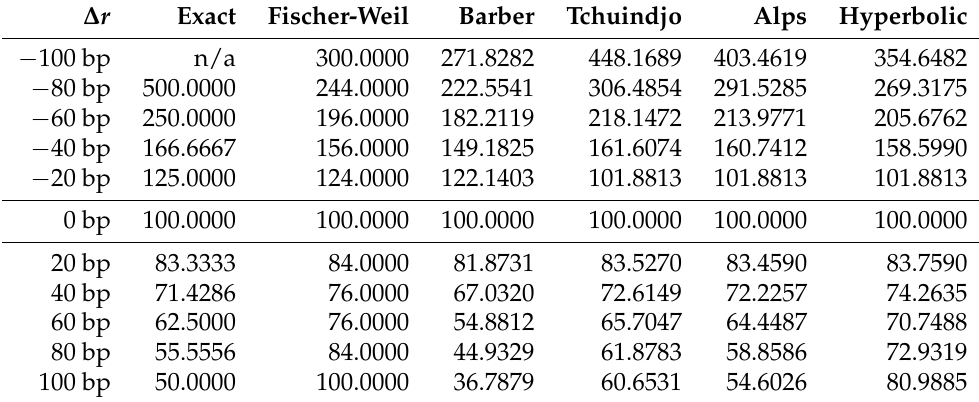
Table 3. Price of a dividend stock with D = 1 and g =